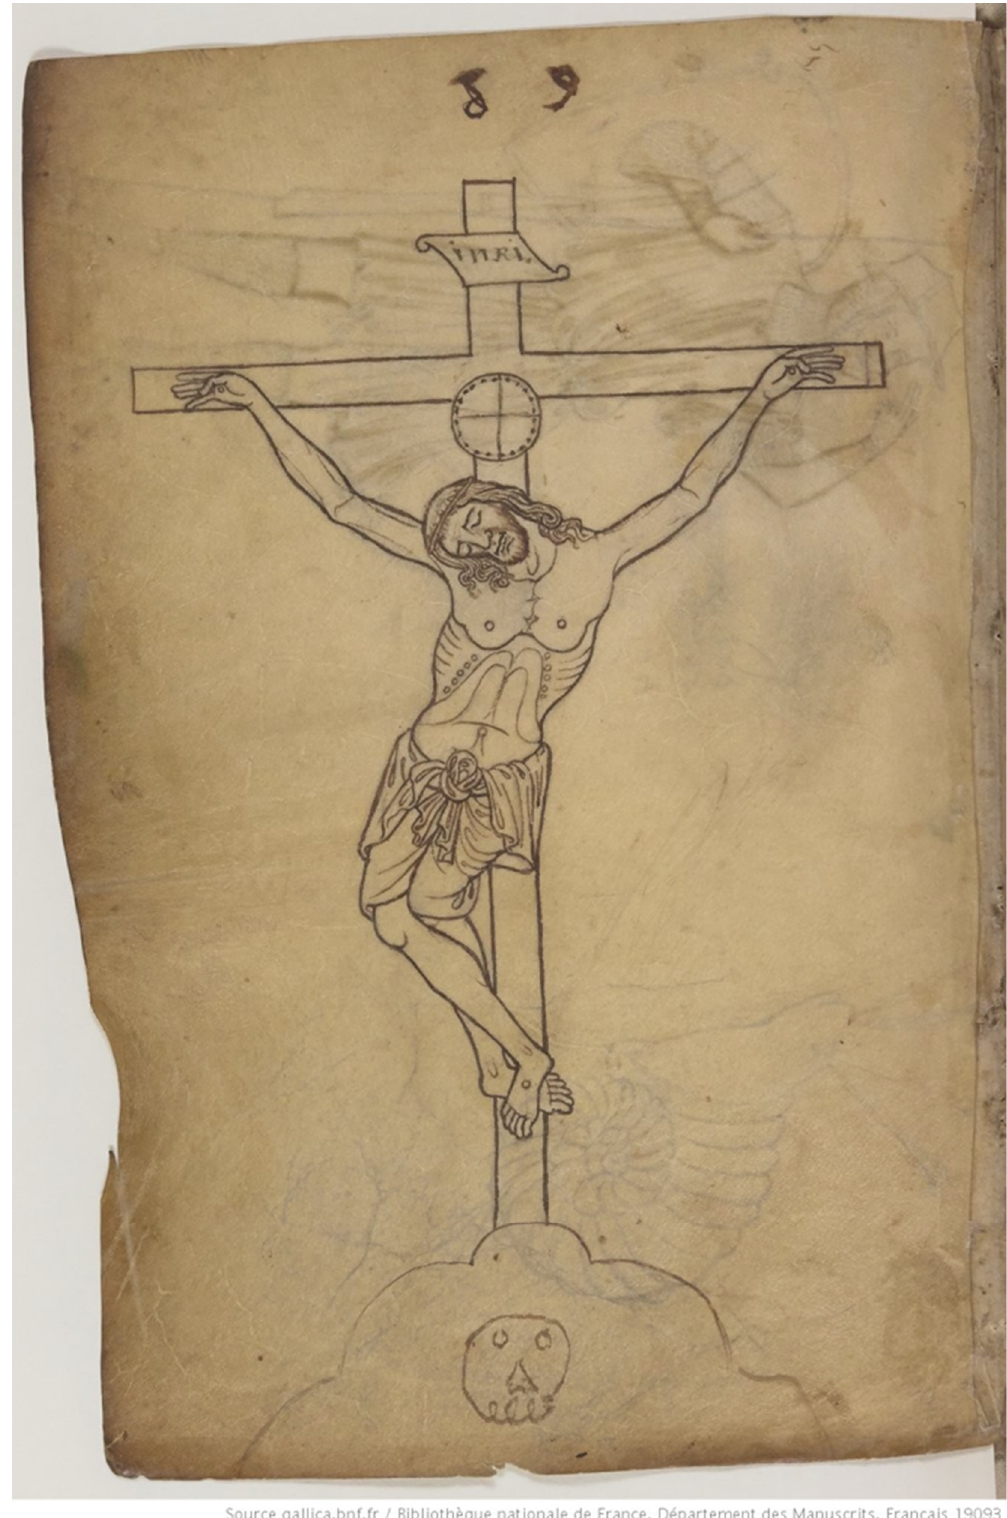
Figure 1. Crucified Christ, Album de dessins et croquis , Villard de Honnecourt, thirteenth century (Français 19093, fol. 2v). Bibliothèque Nationale de France. Département des Manuscrits (Paris). (Source: gallica.bnf.fr/BnF: https://gallica.bnf.fr/ark:/12148/btv1b10509412z/f6.item.zoom) (accessed on 5 May 2022).